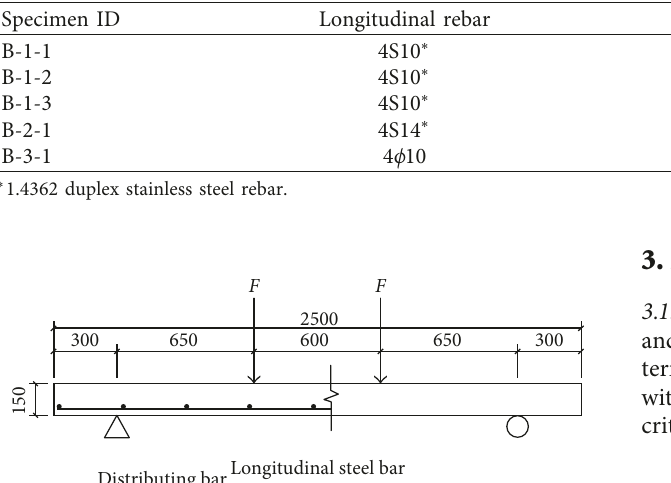
Table 1: Design parameters of the specimens.